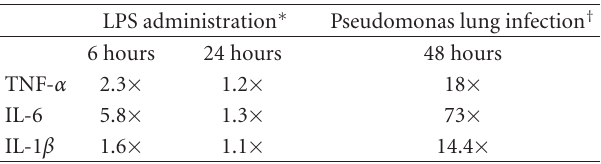
Table 1: Sepsis-induced increases (fold changes) in prototypical proinflammatory cytokines within the